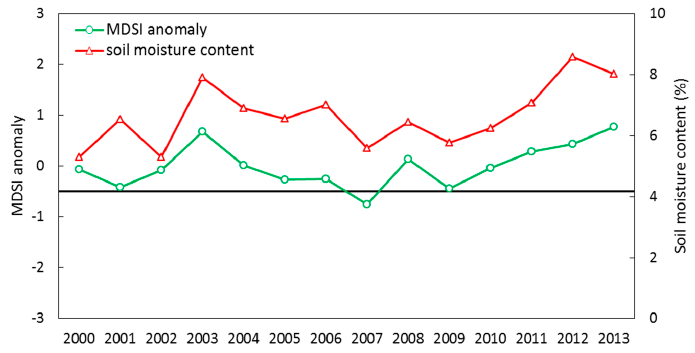
Figure 6. Time series for the MDSI anomaly (green open circles) with soil moisture content (%: light red open triangles) over the sixteen stations in 2000–2013: the horizontal line shows that the MDSI anomaly value is − 0.5 or less for drought condition.